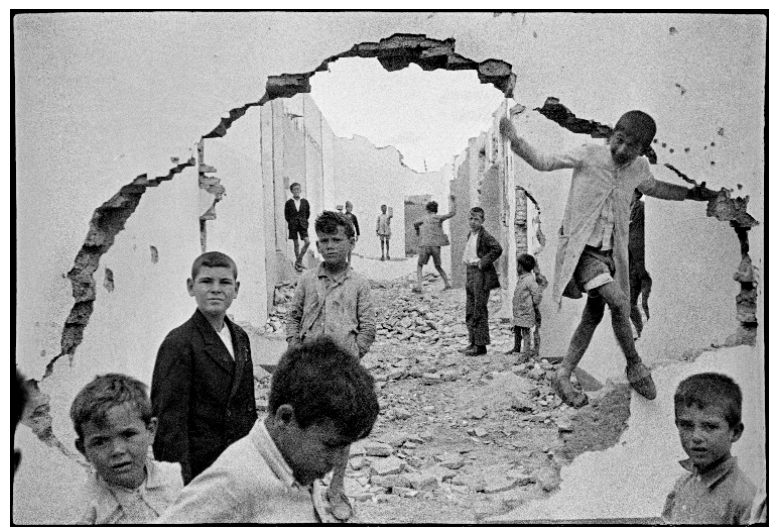
Figure 4. Henri Cartier ‐ Bresson, Spain, Seville, 1933. © Henri Cartier ‐ Bresson/Magnum Photos.